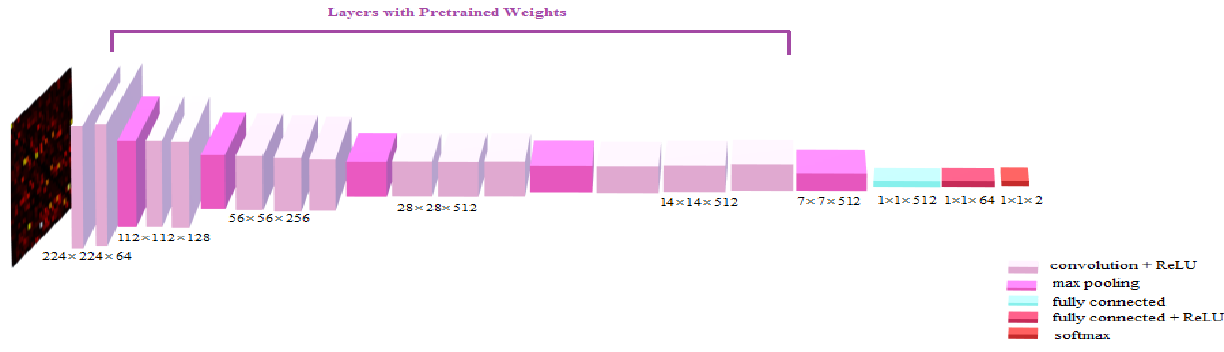
Figure 3. Totally trained network architecture.